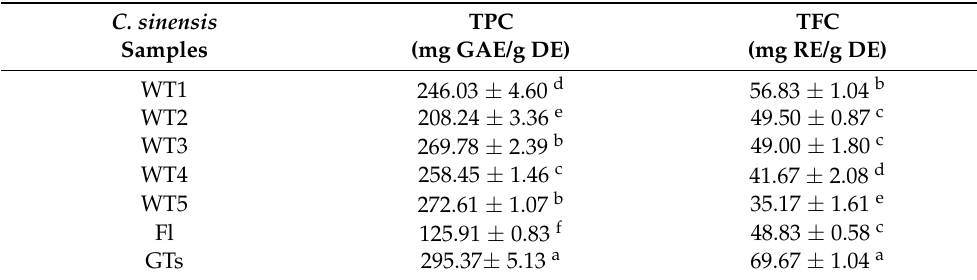
Table 4. Total phenolic content (TPC) and total flavonoid content (TFC) in dry extracts (DE) of different “Pai-Mu-Tan” white tea (WT) and flowers (Fl) samples of Azorean Camellia sinensis var. assamica from Sete Cidades and of commercial green tea samples (GTs) of Azorean C. sinensis var. sinensis from Gorreana Tea Plantation 1